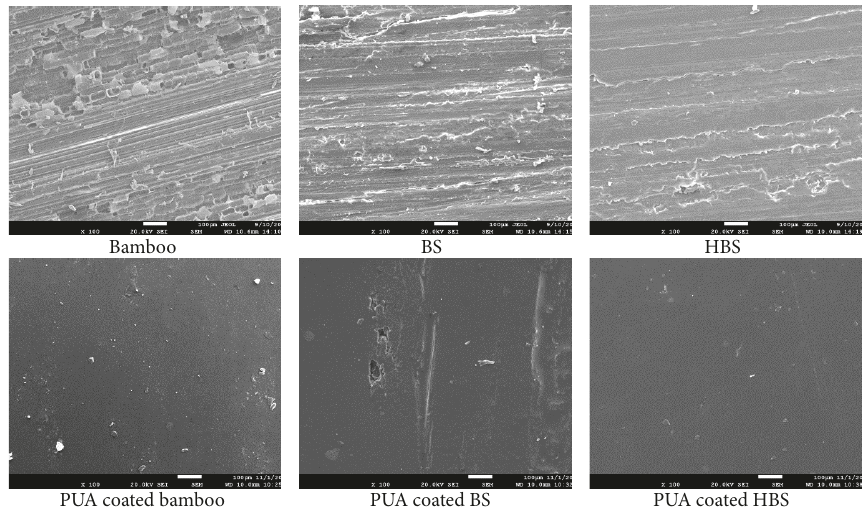
Figure 1: SEM of bamboo, BS, and HBS and their coated